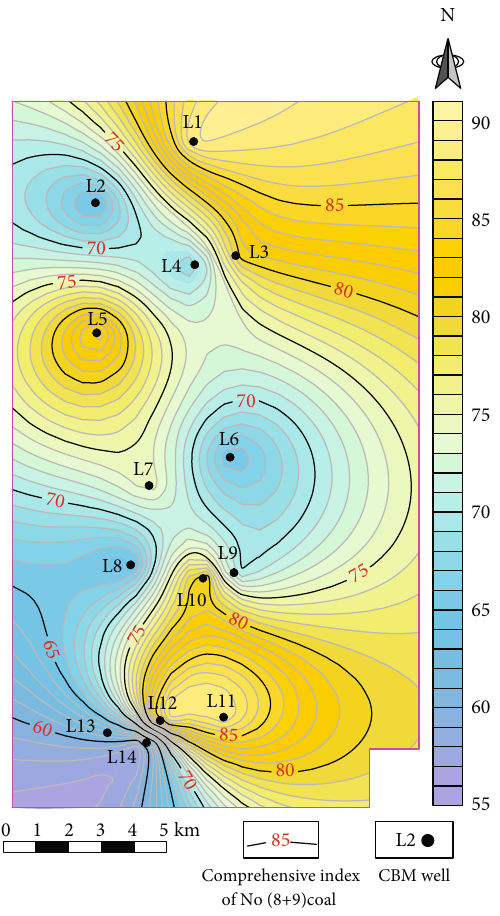
Figure 11: Evaluated and predicted result of the CBM development sweet spot in Yangjiapo block.